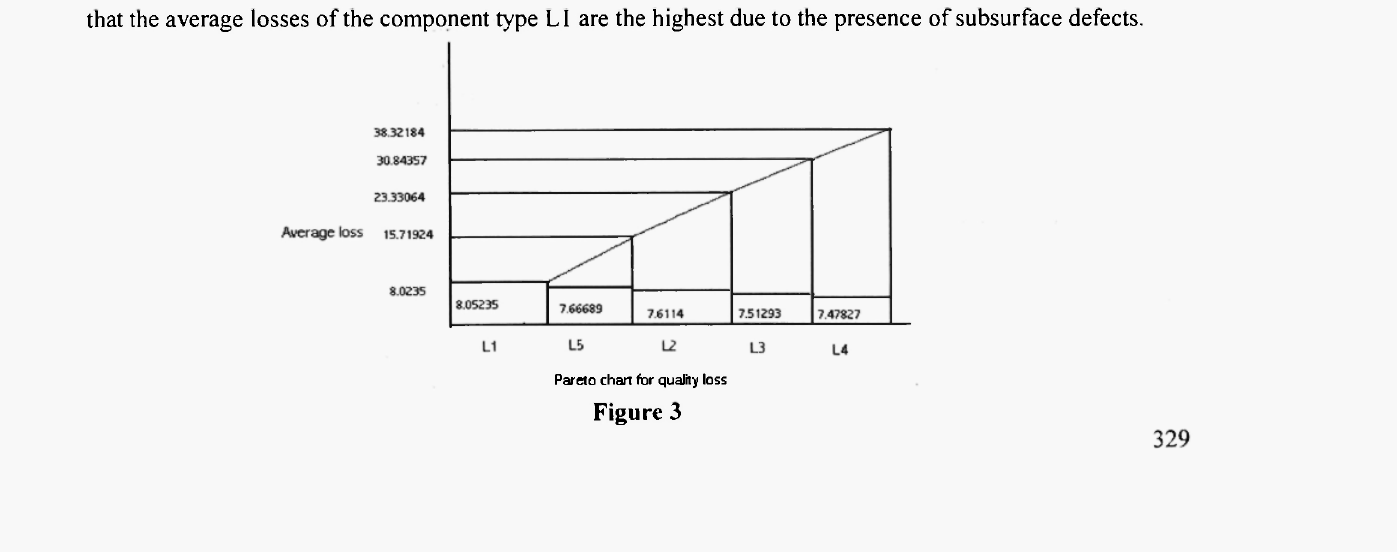
Fig. 2 represents computed average membership values with respect to universal sets. There are various ways to get reasonable membership functions but the probabilities cannot be confused with the degree of membership in a fuzzy set. Membership functions are not probability distribution. In the preliminary stage of the quality control of the welded LPG cylinder is often imprecise. Method of operation of the fuzzy numbers (when the fuzzy set is of a certain restricted type it is called fuzzy number) are extended addition and extended multiplication in order to distinguish them from operations on real numbers. Fig.3 depicts the Pareto chart for quality loss. The Pareto chart clearly indicates that the average losses of the component type LI are the highest due to the presence of subsurface